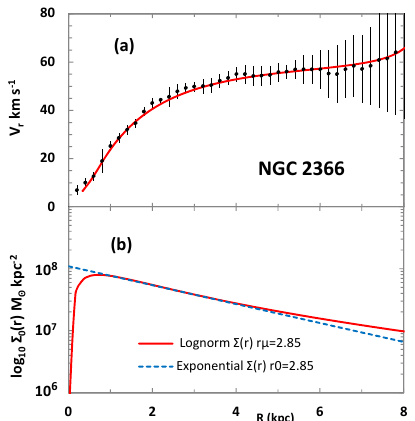
Figure 1. NGC 2366’s ( a ) Rotational velocity for the LN model (solid line) and observations ([38]). ( b ) Radial distribution of density ( M (cid:12) /kpc 2 ) for the LN model (solid line) and Freeman exponential disc model (dashed